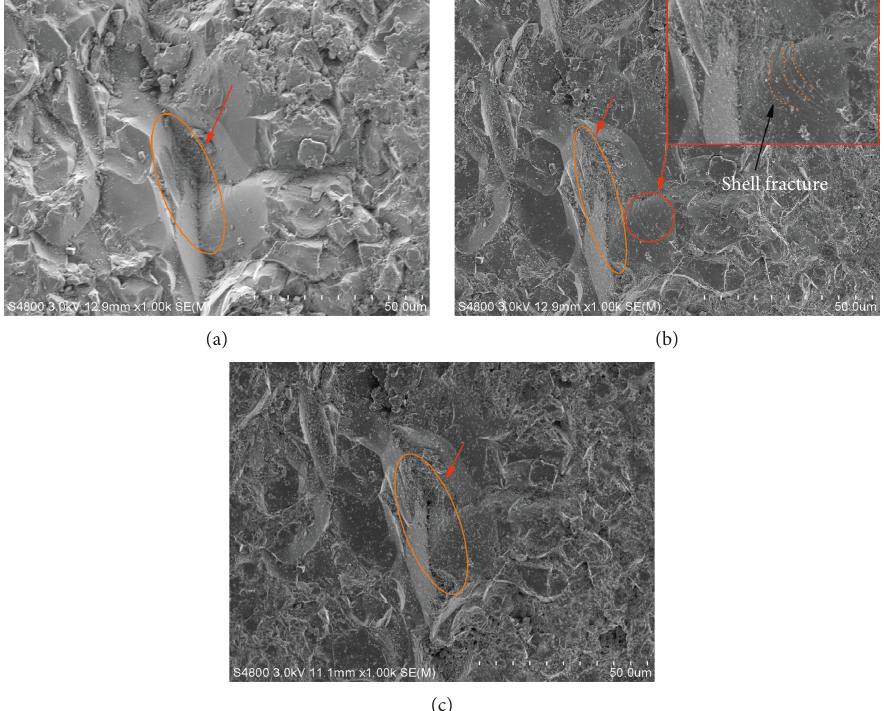
Figure 9: Quartz crack propagation graph. (a) 0min. (b) 2min. (c) 4min.